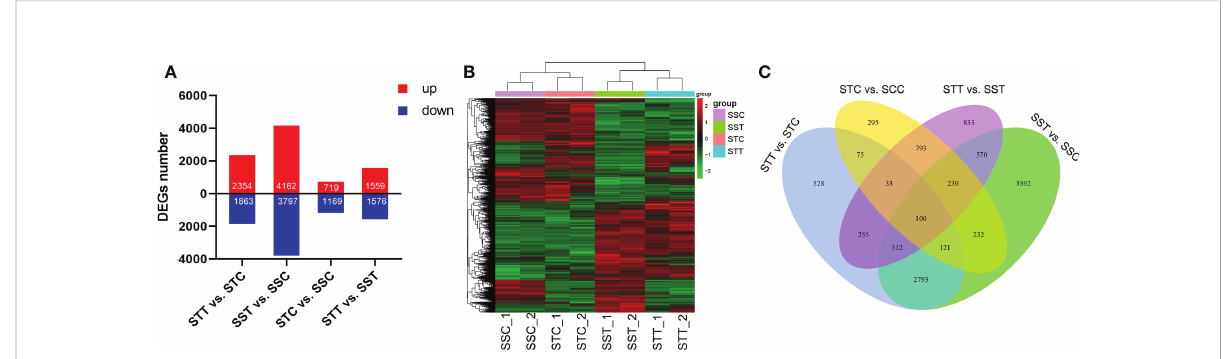
FIGURE 2 Summary of DEGs between salt treatment and control. (A) Number of DEGs in different comparisons. STC: LRNK1-Control, STT: LRNK1-Salt treatment, SSC: LR2381-Control, SST: LR2381-Salt treatment; (B) Expression heatmap of DEGs in different groups. The redder the color, the higher the expression; the greener the color, the lower the expression. (C) Venn diagram analysis results among different comparisons.